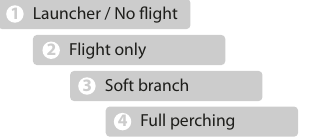
Fig.4|Experimentaldevelopmentprocess. Presentationoftheprocessthatleads to autonomous perching fl